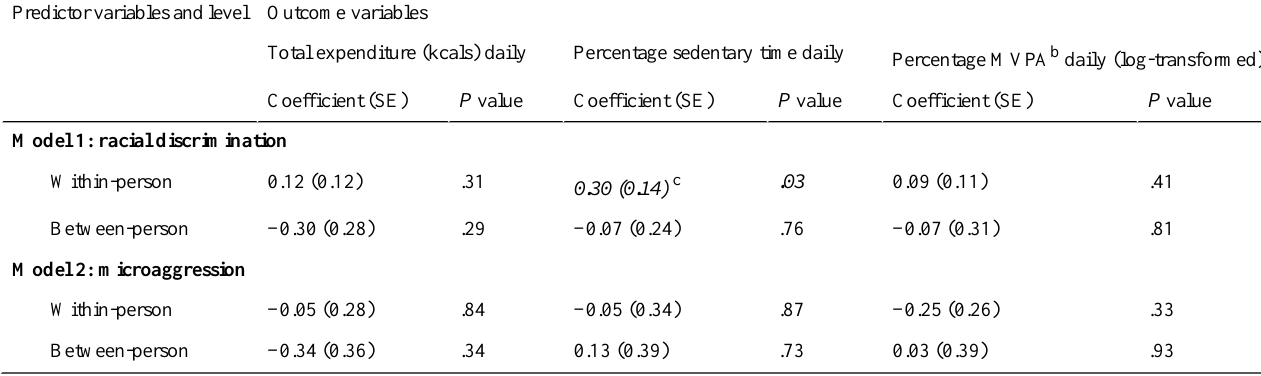
Outcome variablesPredictor variables and